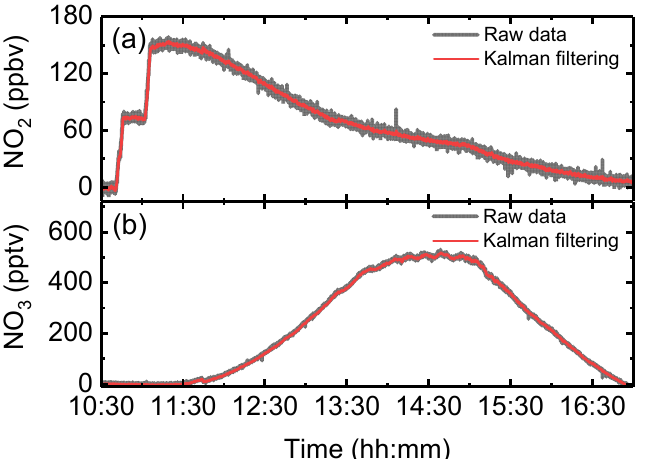
Figure 12. The raw data (grey line) measured by OP-IBBCEAS in reaction chamber experimental conditions, and the measured data after applying with Kalman filtering (red line). ( a ) The measured NO 2 data with and without Kalman filtering. ( b ) The measured NO 3 data with and without Kalman filtering.